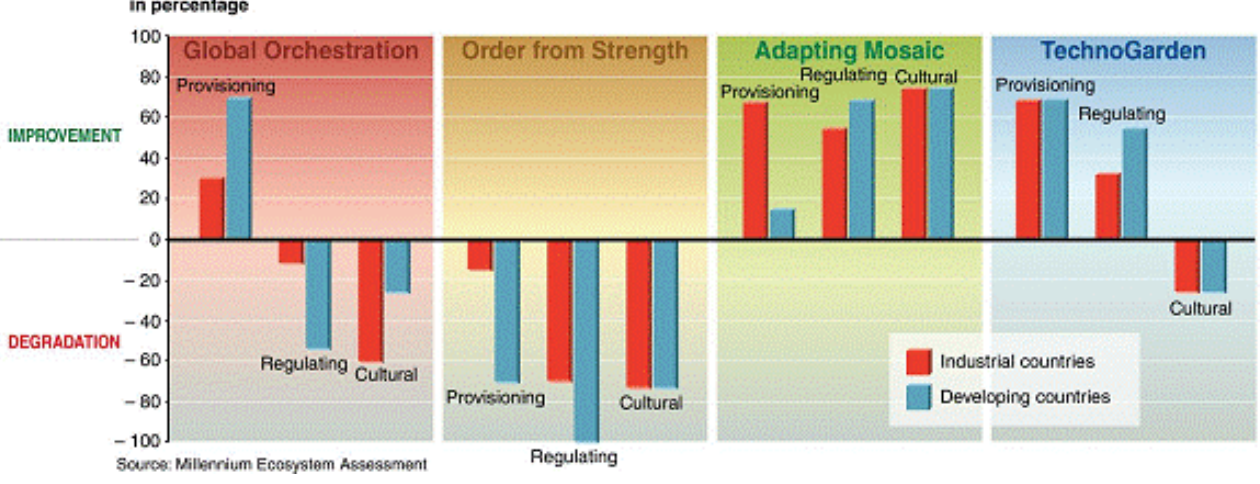
Fig. 3. Provisioning, regulating, and culturally enriching services are shown in all four scenarios, compared with the present, for industrial and developing